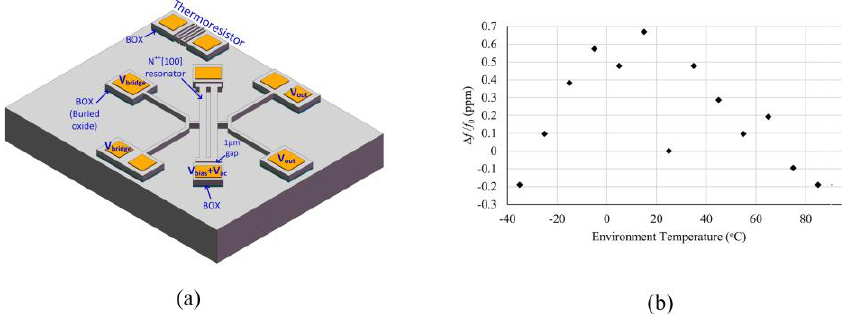
Figure 5. ( a ) Schematic view of the oven controlled resonator [128]; ( b ) The minimum drift of the resonant frequencies at the turnover point is measured to be less than 1 ppm in the temperature range of −35 °C to 85 °C [128]. Table 5. Typical methods of active compensation.